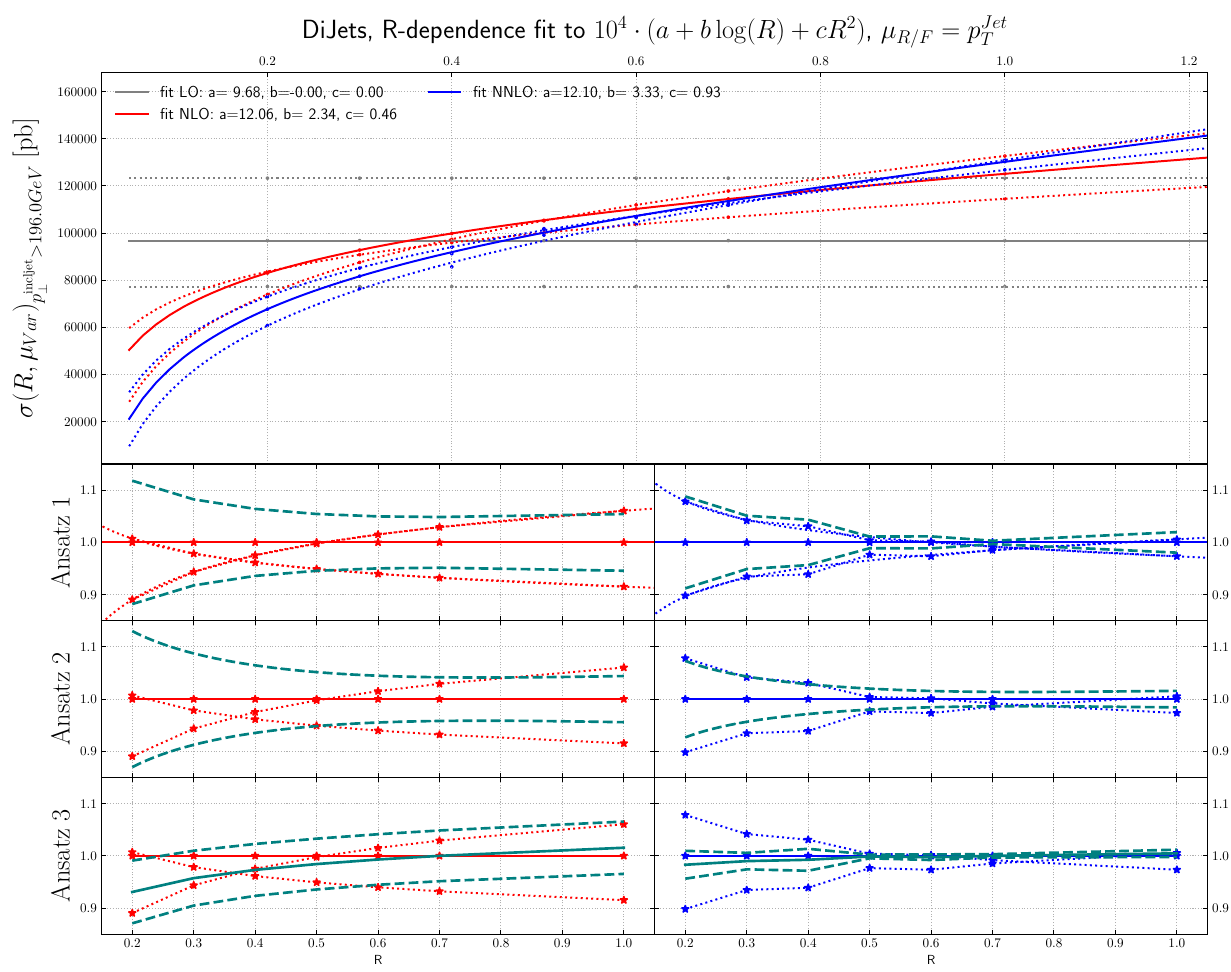
Fig. 10 The R -dependence of the cross sections for inclusive jet production at LO, NLO, NNLO and NLO + PS are shown, for scale variations around a central scale of p jet , as a function of jet radius, for dijet production, for leading jet transverse momenta above 196 GeV T small- R jets and for large- R jets. Note also that the zero- crossing for the curves on the right-hand side is closer to R = 0 . 9 than to R = 0 .